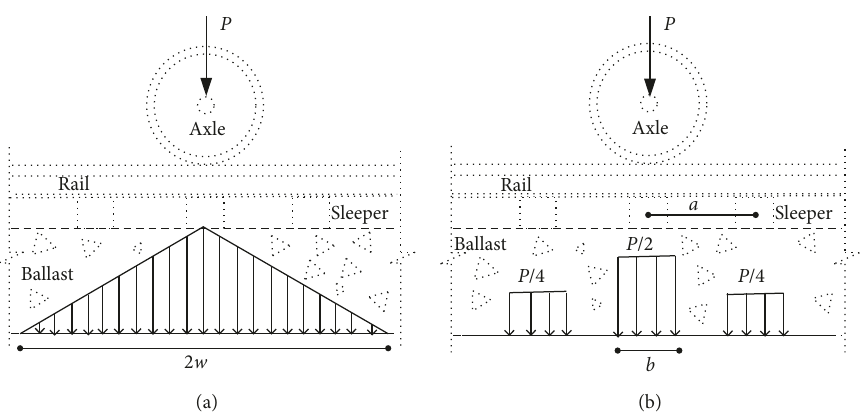
Figure 1: Shapes of load distribution on the bridge deck. (a) Triangular distribution. (b) Three-block distribution in